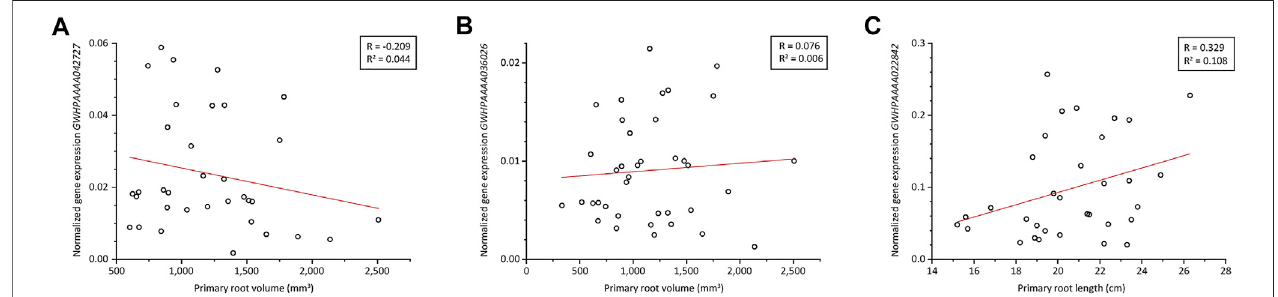
FIGURE4| Expressionanalysisofthreecandidategenesidenti fi edinthe T.koksaghyz roottranscriptome.Geneexpressioninsingle T.koksaghyz wild-typeplants was determined by qRT-PCR. Normalized gene expression of GWHPAAAA042727 (A) and GWHPAAAA036026 (B) was plotted against the primary root volume in the upper 5 cm, and normalized gene expression of GWHPAAAA022842 (C) was plotted against the primary root length. Normal distribution of all parameters was con fi rmed using the Kolmogorov-Smirnoff-test, and outliers were identi fi ed using Grubbs ’ s test. Red line (cid:1) regression line; R (cid:1) Pearson ’ s R correlation coef fi cient; R 2 (cid:1) coef fi cient of determination; n (cid:1) 33 –